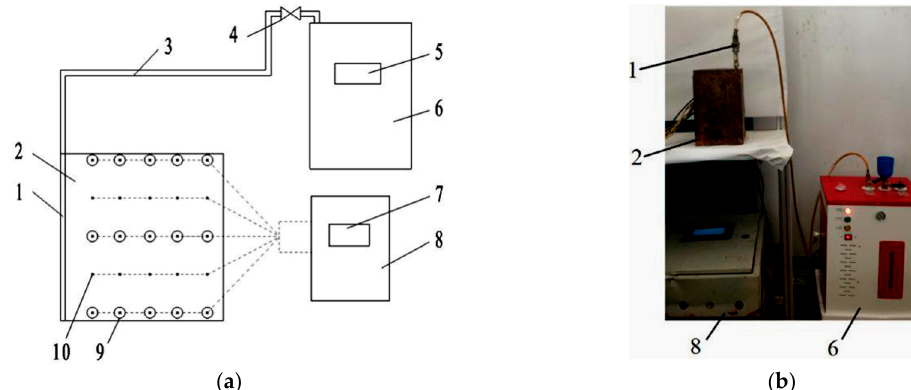
transport pipe; 4. ball valve switch; 5. boiler pressure controller; 6. boiler; 7. control box screen; 8.